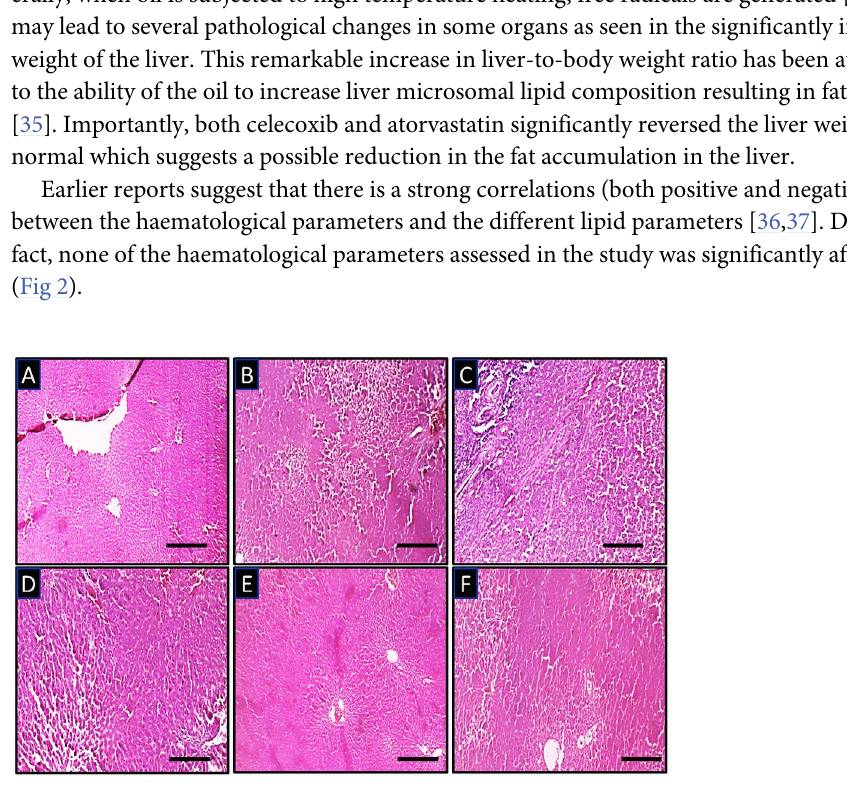
PLOS ONE | https://doi.org/10.1371/journal.pone.0247735 August 17,